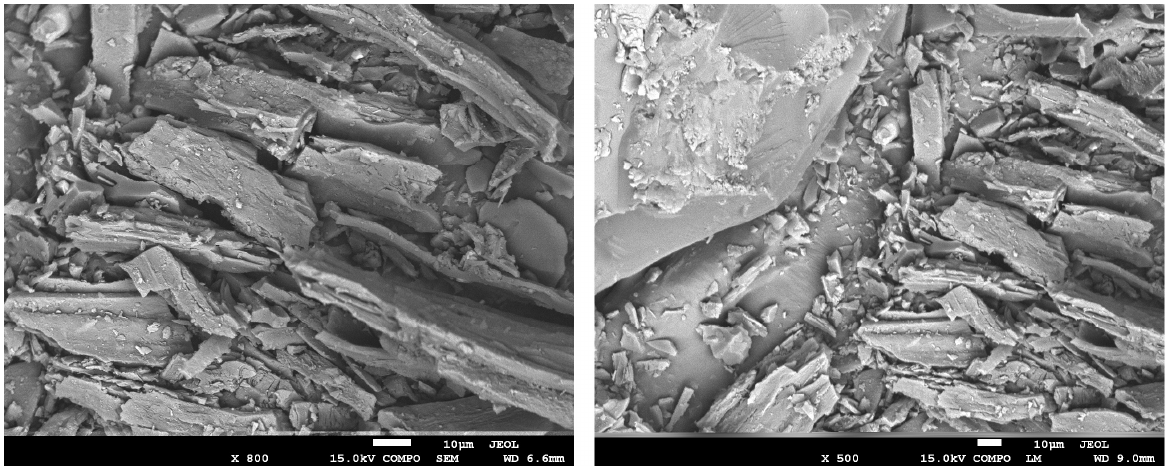
Figure 2. SEM images of the surface of sample P2.